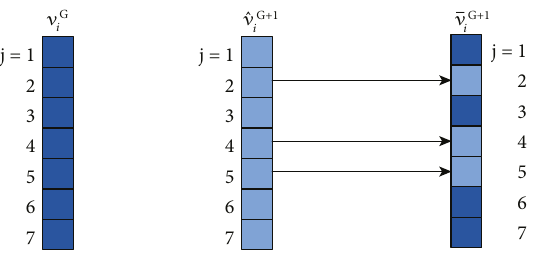
Figure 7: Recombination process of the DE